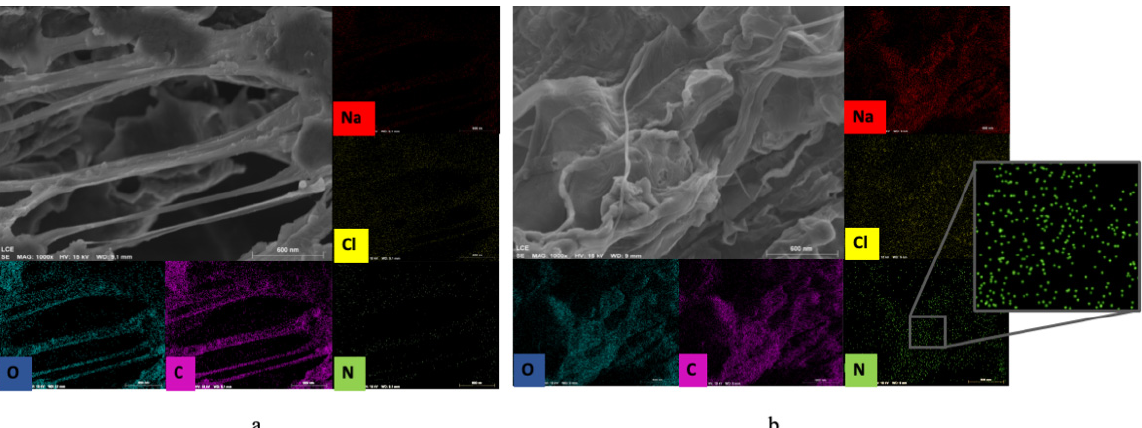
Figure 5. EDX map from the conditions of validation resulting in the option of samples: ( a ) sample V2, 7.7% of PEO and 0.36% of NaCl; ( b ) sample V4, 8.0% of PEO.